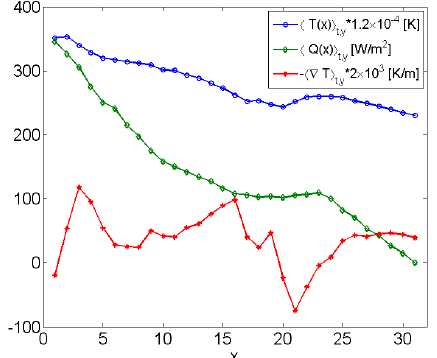
Figure 13. Averaged (in t and y ) profiles calculated from the origi- nal full temperature maps, for temperature (blue), heat flux (green), and negative temperature gradient (red).